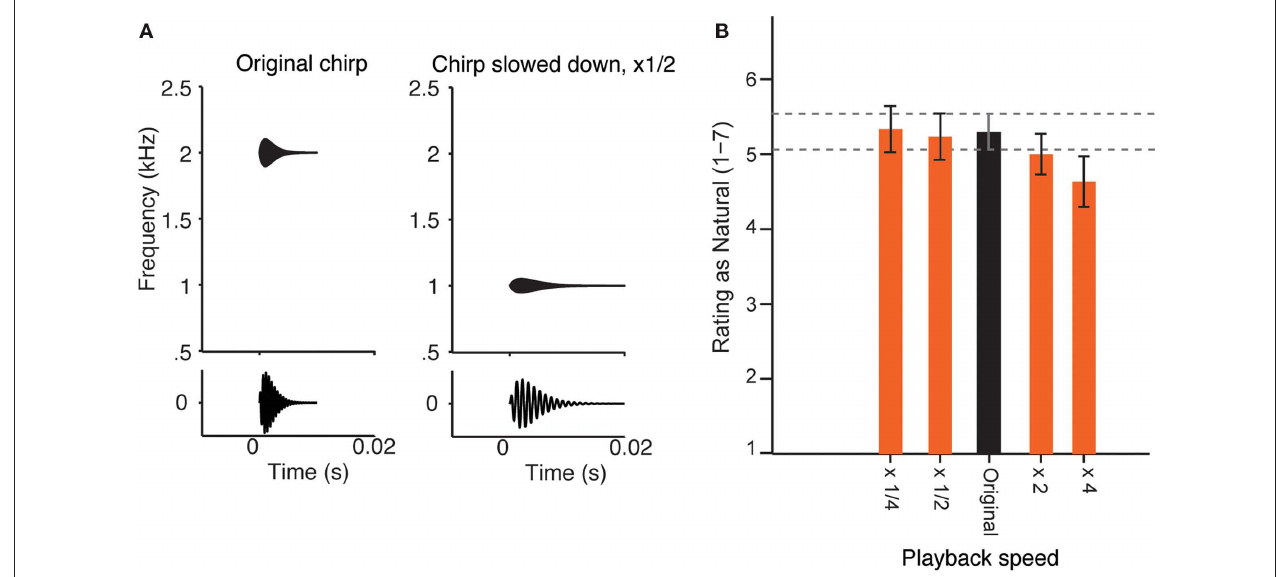
at five different speeds ( × 1/4 slowed down by a factor of 4; × 1/2 slowed down by a factor of 2; Original; × 2 accelerated by a factor of 2; × 4 accelerated by a factor or 4), on the scale from 1 (most unnatural) to 7 (most natural). Error bars = SEM. There was no significant effect of speed on the rating in a one-way ANOVA [ F (4, 26) = 1.030, n.s.)], and the pair-wise comparison with Dunnett correction for multiple comparisons did not reveal any significant differences between